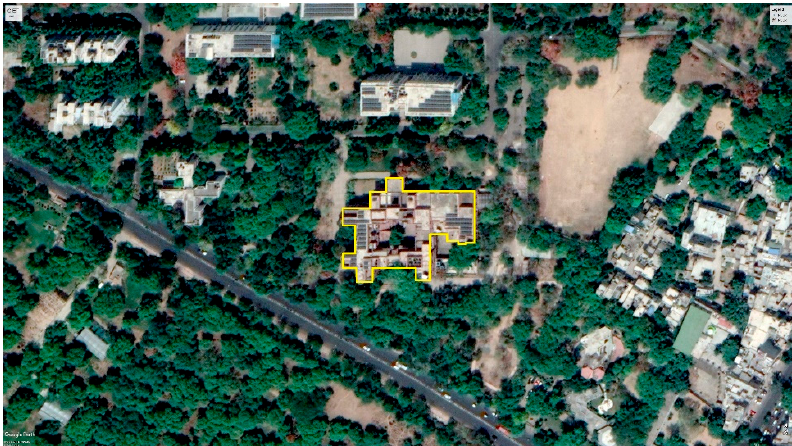
Figure 8. Satellite image of the Central Institute of Educational Technology (CIET) building located on the southern edge of the National Council of Educational Research and Training (NCERT) campus (Image courtesy of Google Earth).